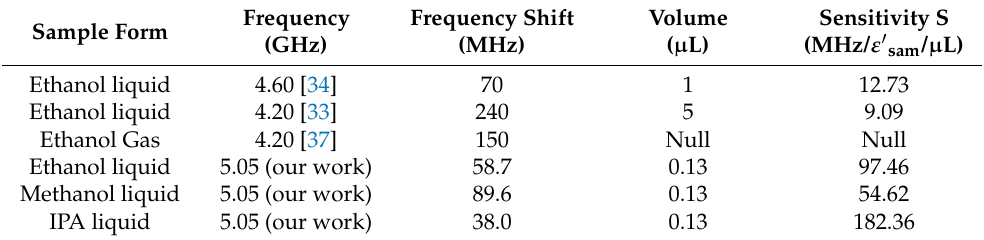
Table 8. Comparison table of proposed sensor and other